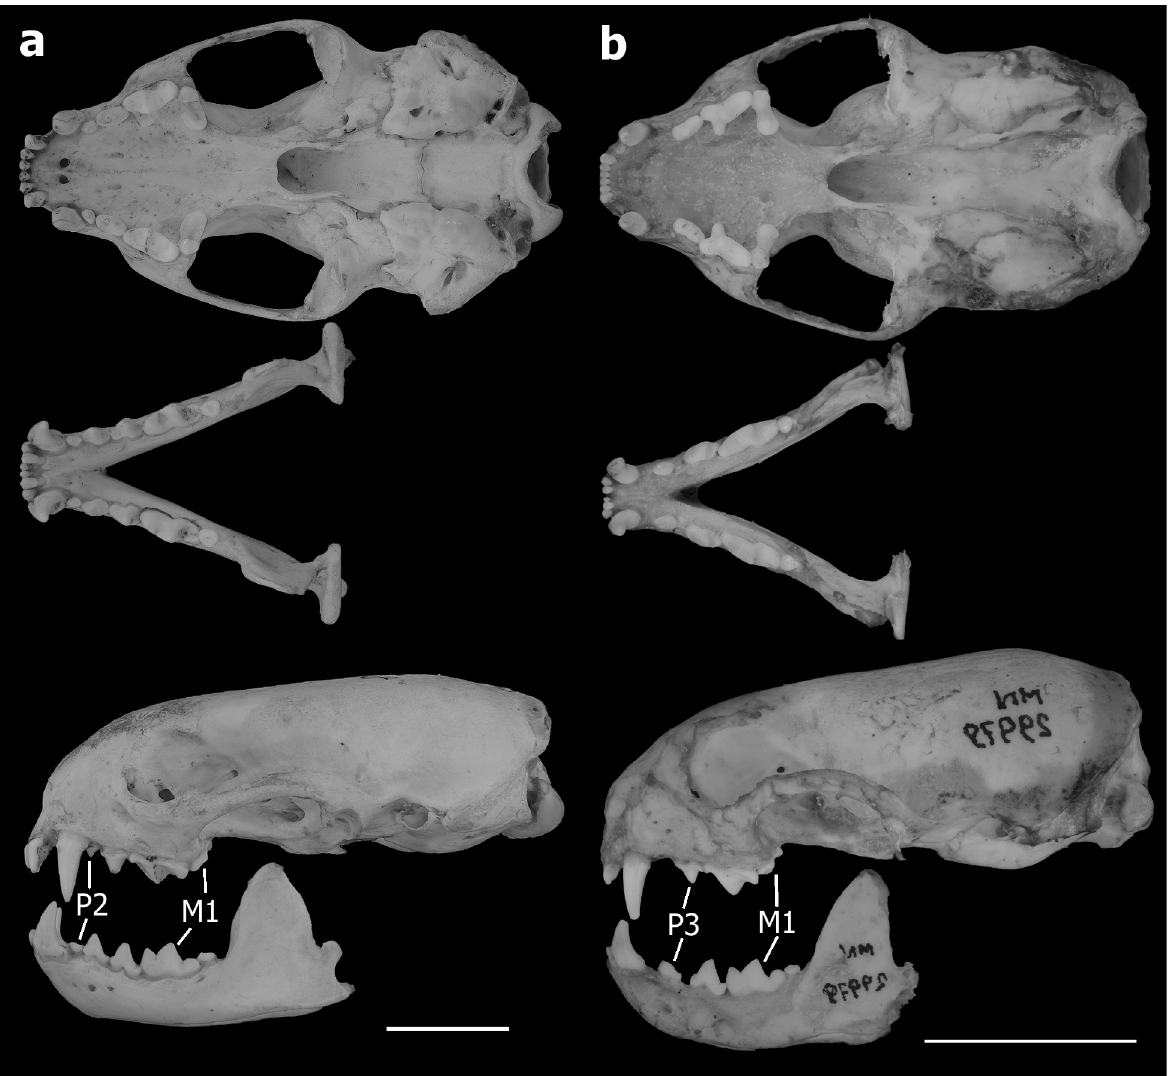
Figure 6. Occlusal (top) and lateral (bottom) views of the skull and mandible of a) Galictis cuja (MN29998); b) Mustela africana (MN29979). The lateral view of M. africana skull was mirrored horizontally to facilitate understanding. Abbreviation “P” means premolars and “M” molars. Scale bar =